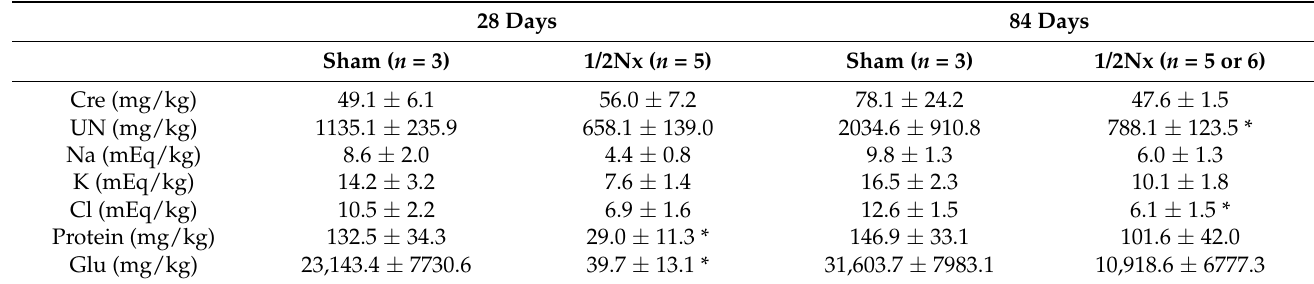
Table 4. Biochemical parameters in urine of Sham operated and 1/2Nx DEK rats.